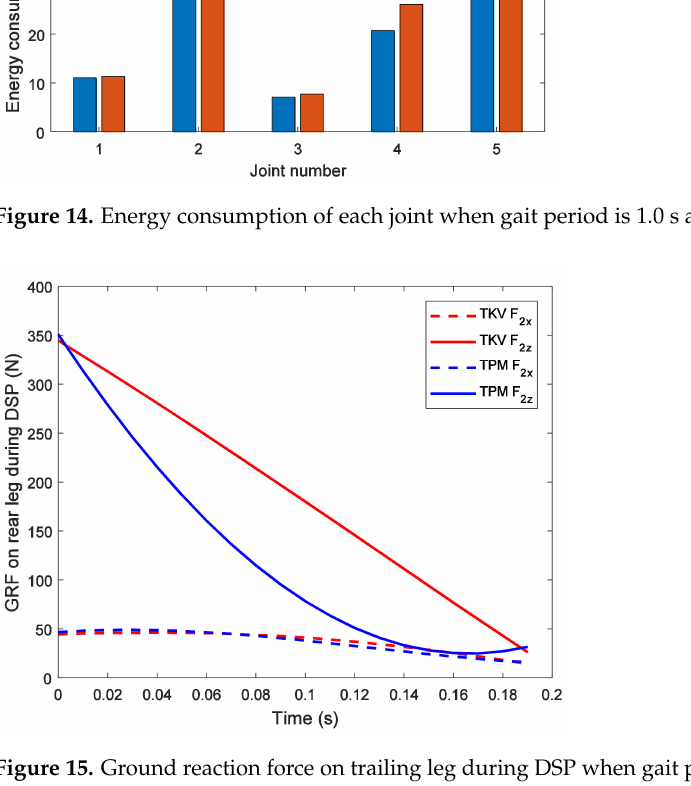
Figure 15. Ground reaction force on trailing leg during DSP when gait period is 1.0 s and step length is 0.3